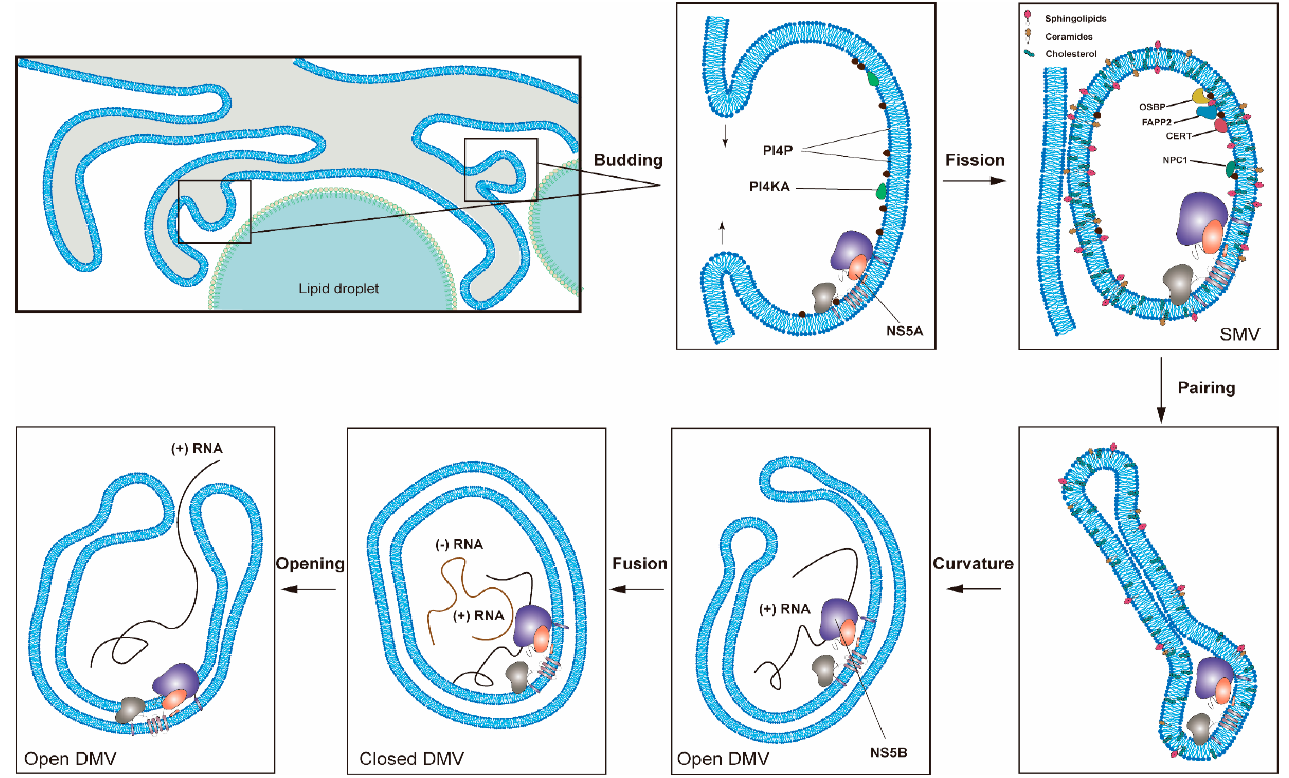
Figure 2. One proposed model for the formation of HCV replication organelles (RO). Double-membrane vesicles (DMV) biogenesis is a complex process possibly requiring several membrane remodeling steps, including budding, fission, pairing, curvature, and fusion [11,17]. HCV DMV formation can be induced by NS5A with the help of other nonstructural proteins [25,26]. HCV activates the lipid kinase PI4KIII α to generate enhanced levels of PI4P, which in turn attracts lipid transport proteins (e.g., OSBP, FAPP2, NPC1 and CERT) delivering cholesterol and glycosphingolipids into DMVs. PSTPIP2, a protein with membrane-deforming activity, and PLA2G4C are also critical for membrane web (MW) formation. HCV RNA replication can be conducted by NS5B with the help of other nonstructural proteins in the closed DMVs. After the completion of HCV genomic RNA synthesis, the newly synthesized viral RNAs will be released from the open DMVs (possibly with Kaps or Nups) for translation or virion assembly. Other possible models for DMV formation have also been proposed [11].